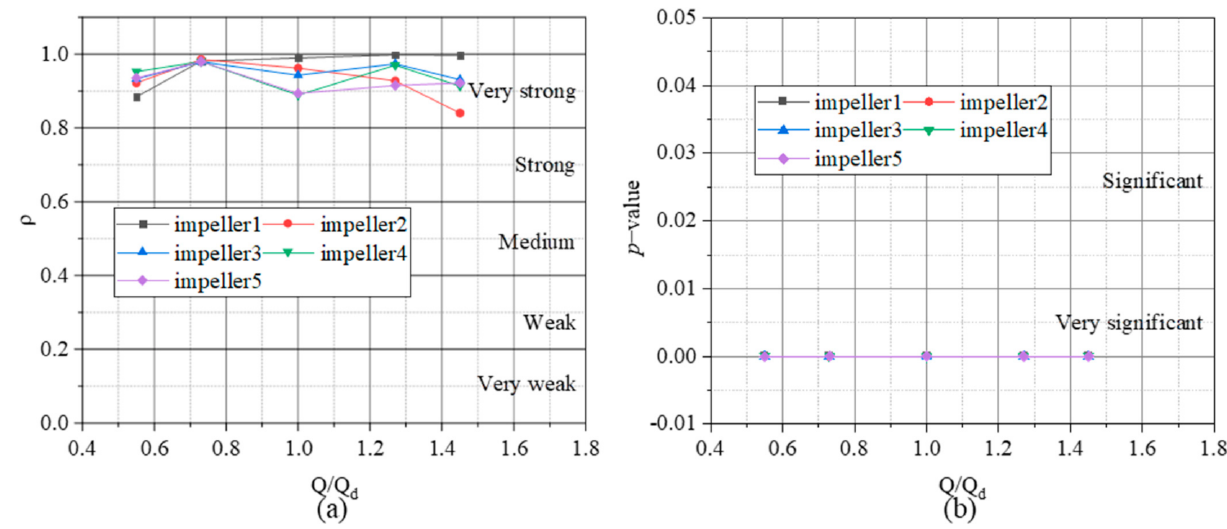
Figure 16. The correlation between WEPR and skin friction coefficient, ( a ) Pearson correlation coef‑ ficient, ( b ) p